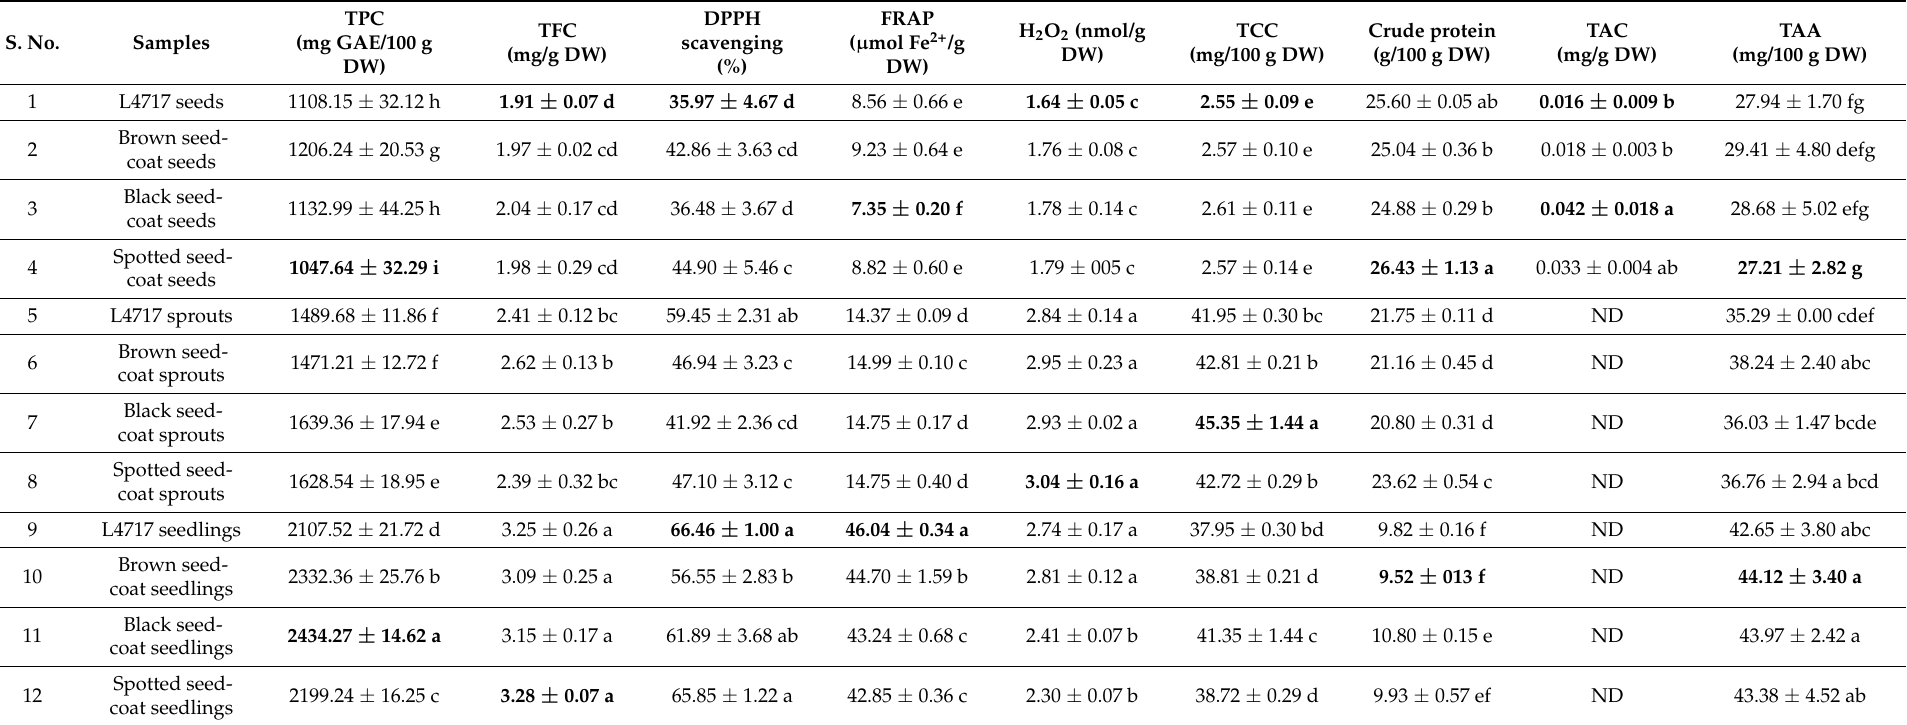
Table 3. Biochemical characterization of lentil genotypes differing for the seed coat